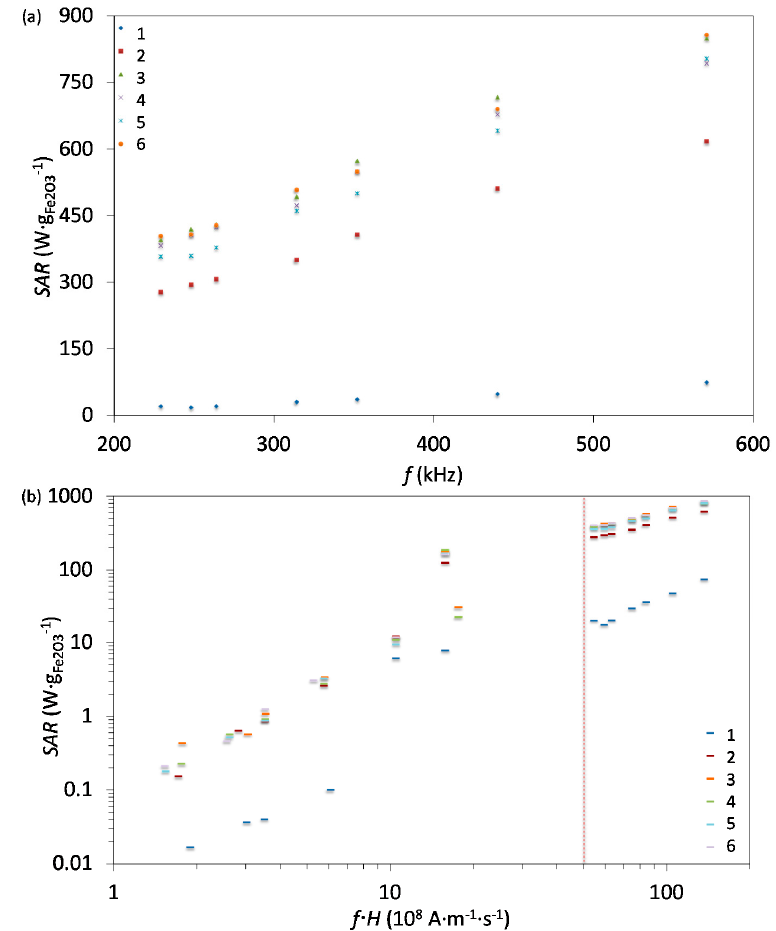
Figure 6. ( a ) SAR values as a function of frequency at the field amplitude of 23.9 kA·m − 1 measured for all 6 samples. ( b ) SAR values as a function of the f·H product for measured values of f and H . The vertical dashed lines indicate two biological limits for the f·H product depending of the exposed volume, which corresponds to indicated hyperthermia coil size.